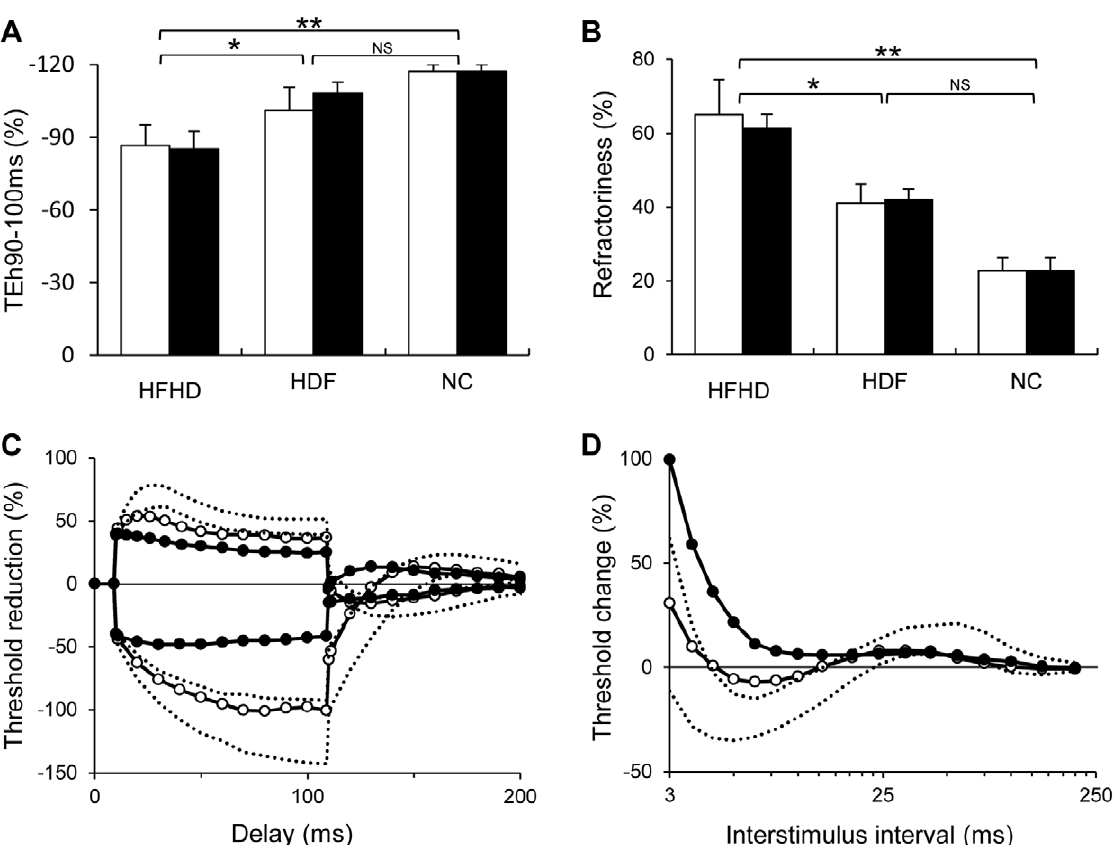
Figure 3. Longitudinal follow-up 18 months of patients who remained on their respective treatment (HDF n=4 and HFHD n=7). Panels (A) and (B) demonstrate a relative stability of nerve excitability results in patients who remained on their respective treatments at baseline (white bars) and longitudinal follow-up (black bars). Additionally these graphs depict the sustained significant difference between HDF and HFHD in both hyperpolarising threshold electrotonus 90–100 ms (TEh90–100 ms) and refractoriness. * p , 0.05, ** p , 0.001. Panels (C) and (D) show the results of a single patient switched from HDF to HFHD. Threshold electrotonus (C) and recovery cycle parameters (D) demonstrate the profound abnormalities at longitudinal follow-up on